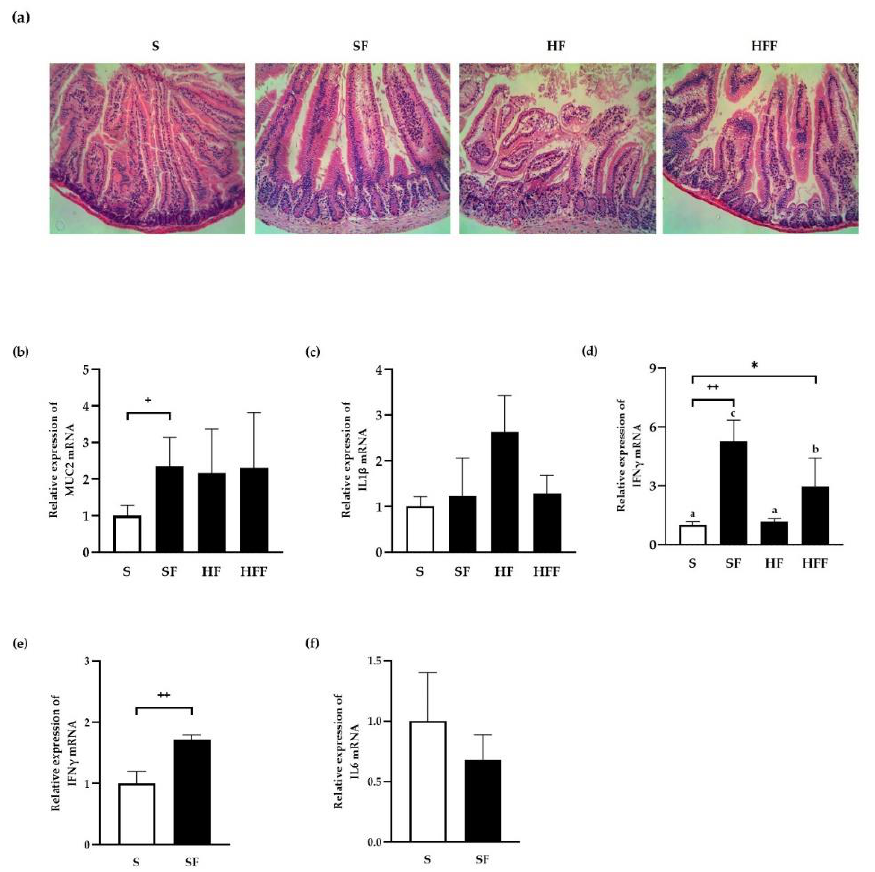
Figure 5. Anti-inflammatory effect of ferulic acid in vivo. The mice were fed a chow diet or a high-fat diet supplemented with 50 mg/mL FA for 8 weeks, and then whole intestinal tissues were harvested for H&E staining with 10 × magnification ( a ) and qPCR measurements of Mucin 2 ( b ), IL1 β ( c ), and IFN γ ( d ). Small intestine epithelial cells (IEC) were used to quantify IFN γ ( e ) and IL6 ( f ) by qPCR. Data are expressed as means ± SEM. Duncan’s multiple range test was performed after one-way ANOVA to determine the significances of group differences expressed as *: p < 0.05 and indicated by different letters. The significances of the effects of FA compared to control group were analyzed using the Student’s t -test + : p < 0.05; ++ : p < 0.01. S: standard chow diet; SF: standard chow diet supplemented with 50 mg/mL FA; HF: high-fat diet; HFF: high-fat diet supplemented with 50 mg/mL